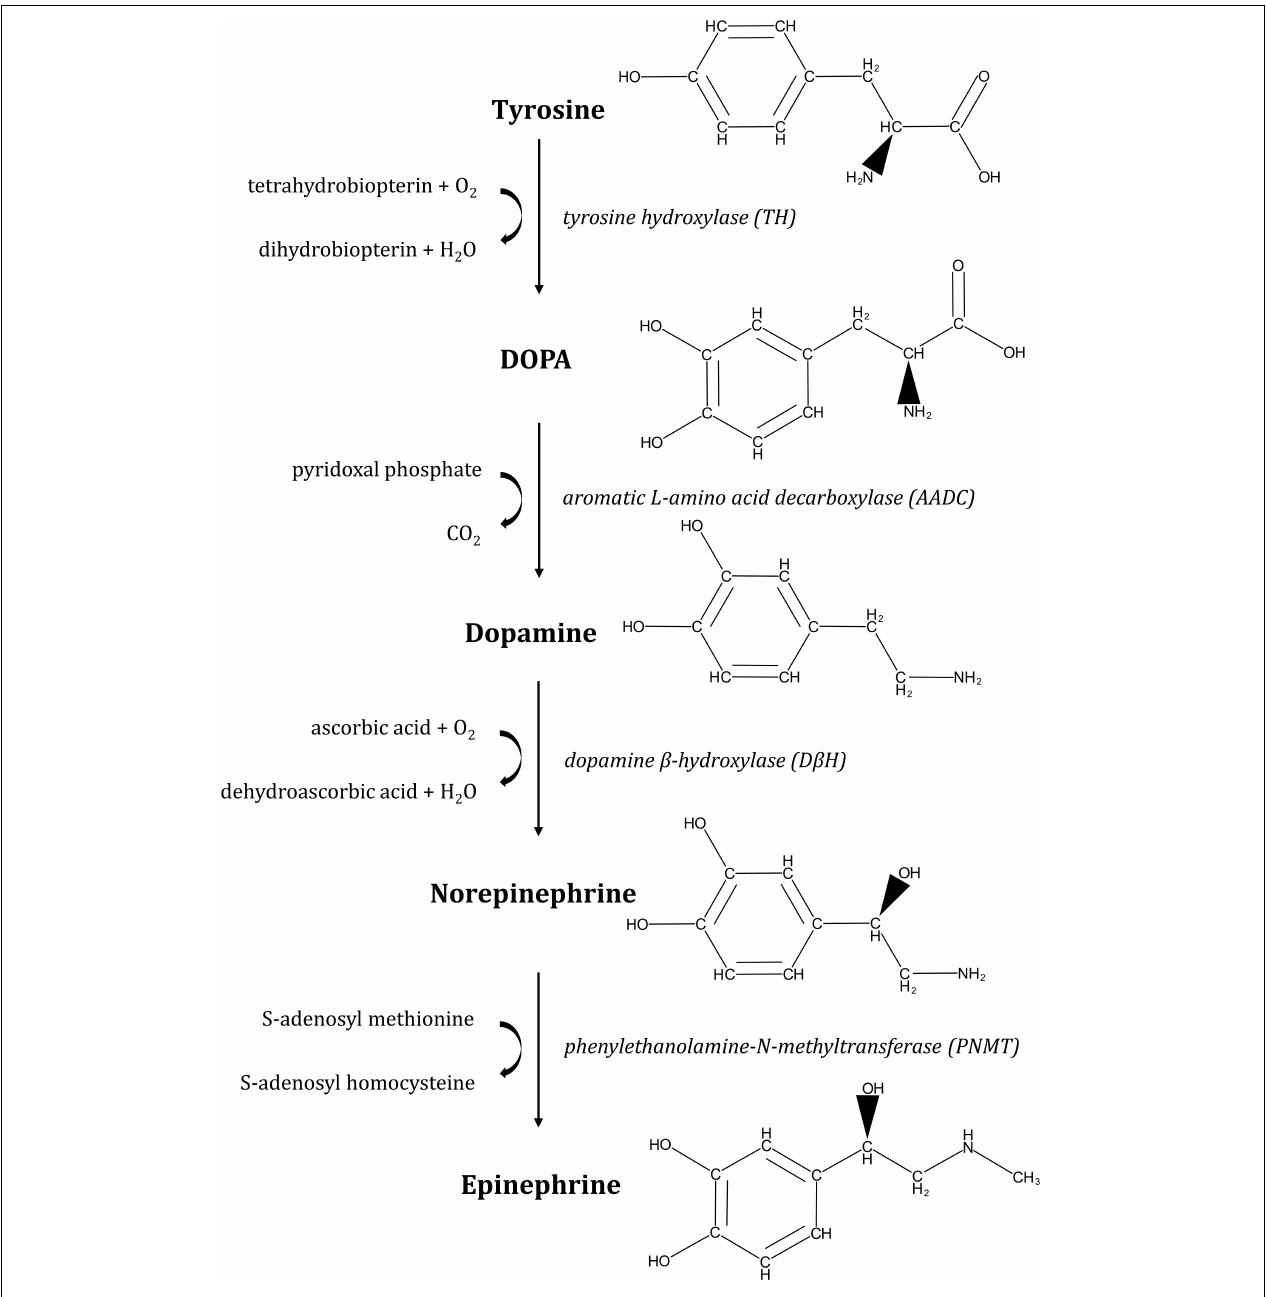
FIGURE 1 | Pathway of epinephrine and norepinephrine biosynthesis. Synthesis of catecholamines starts with conversion of L -tyrosine to L -dopa by tyrosine hydroxylase (TH). Then, L -dopa is processed to dopamine by L -aromatic amino acid decarboxylase (AADC), from where norepinephrine is formed by dopamine- β -hydroxylase (D β H). Finally, epinephrine is synthesized by addition of a methyl group to norepinephrine by phenylethanolamine- N -methyltransferase (PNMT). In mammals, catecholamines are synthesized from L -Dopa, obtained from dietary sources (the amino acids tyrosine and